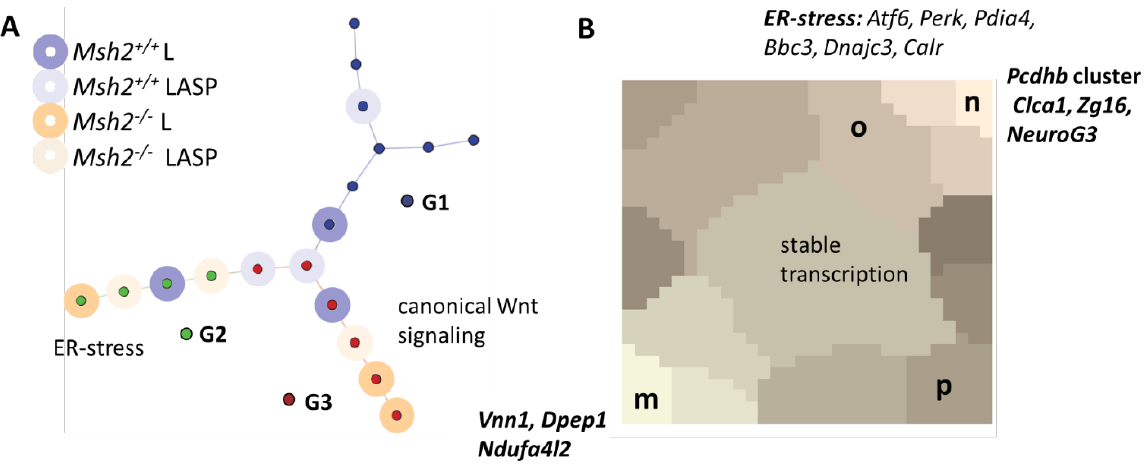
Figure 6. Transcriptional profiles of the organoid samples. ( A ) Correlation spanning tree based on the SOM analysis of RNA-seq data on the short- and long-term organoid cultures (ASP: aspirin-supplemented cultures). Unsupervised clustering identifies 3 groups of samples. Group 1 (G1, blue) comprises all samples from the short-term organoids. Groups 2 (G2, green) and 3 (G3, red) comprise samples of the long-term organoids only. ( B ) K-means cluster of the RNA SOM. Cluster m comprises genes that become downregulated during culture, while cluster n genes become upregulated. Selected genes are indicated. The clusters o and p are associated with genes exclusively upregulated in group 2 and group 3, respectively. Their genes are enriched in the GO sets related to “response to endoplasmic reticulum stress” and “canonical Wnt signaling”. Examples are provided for both sets. Genes of other clusters show intermediate regulation.